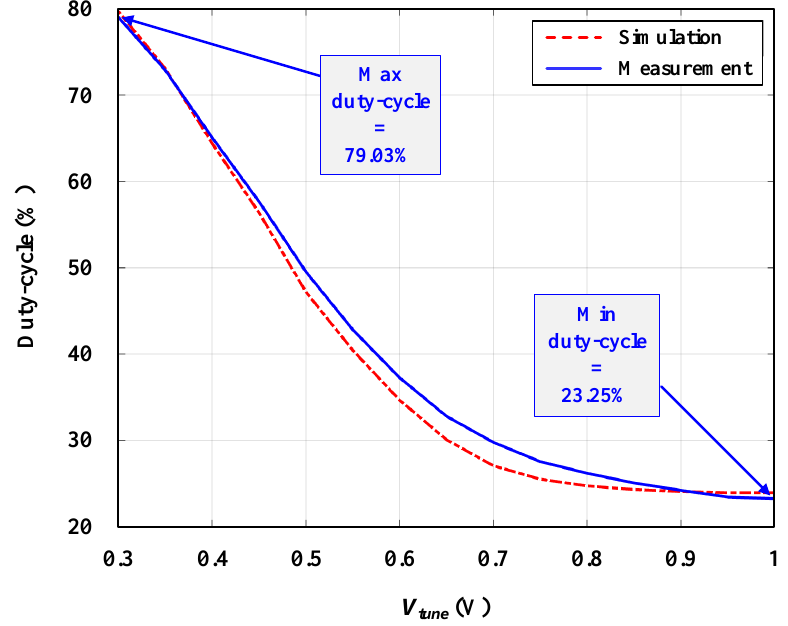
Figure 14. Measured tunable duty-cycle from 23.25% to 79.03% compared to